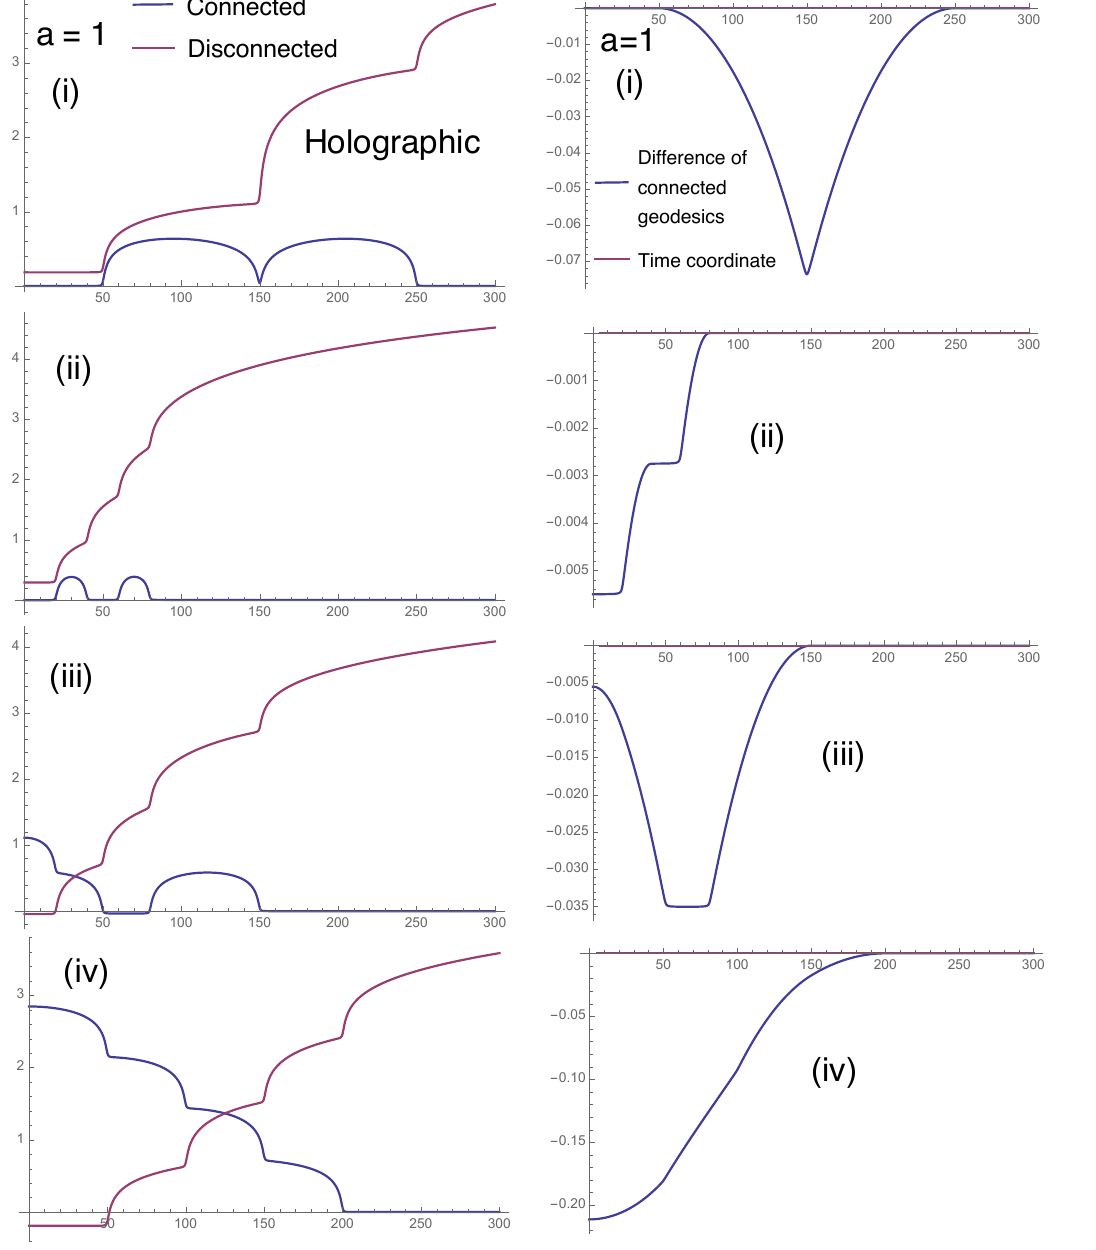
Figure 17 . The plots of (cid:1) S con = dis ;D for the double joining local quench (left) and the di(cid:11)erence A (cid:1) S con ;D (cid:1) S con ;S ( x = b ) (cid:1) S con ;S ( x = (cid:0) b ) between the double and single quench (right) as a function A (cid:0) (cid:0) of t . We set b = 50 and a = 1. From the top to bottom we presented results for the four di(cid:11)erent setups (i), (ii), (iii) and (iv). Left: in the left plots, the blue and red graph describes (cid:1) S con and (cid:1) S dis , respectively. Right: in the right plots, the blue graphs describe the di(cid:11)erence A A (cid:1) S D (cid:1) S S ( x = b ) (cid:1) S S ( x = (cid:0) b ) for the connected geodesic, while the red line just shows the axis of A (cid:0) A (cid:0) A time coordinate.